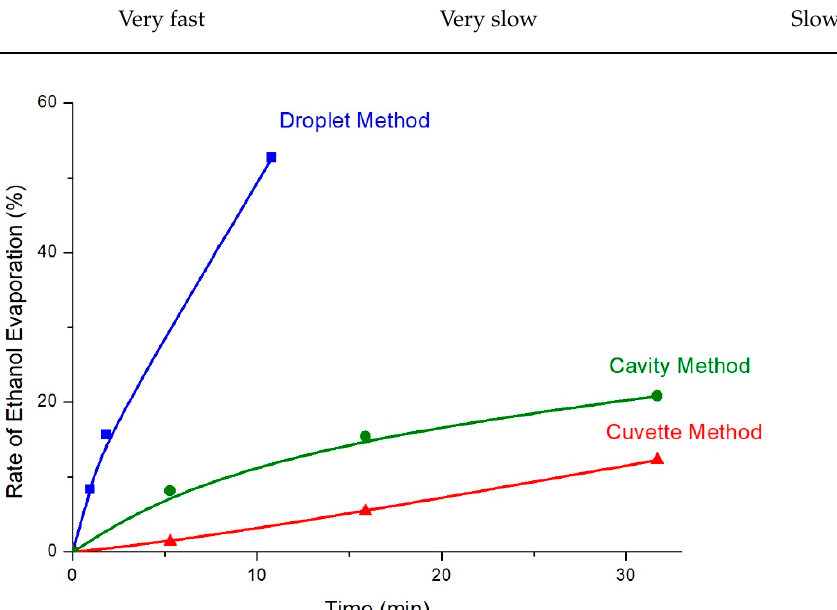
Figure 11. Rate of ethanol evaporation as a function of time for the method of droplet, the method of cuvette, and the method of the gold-coated glass slide with cavity.